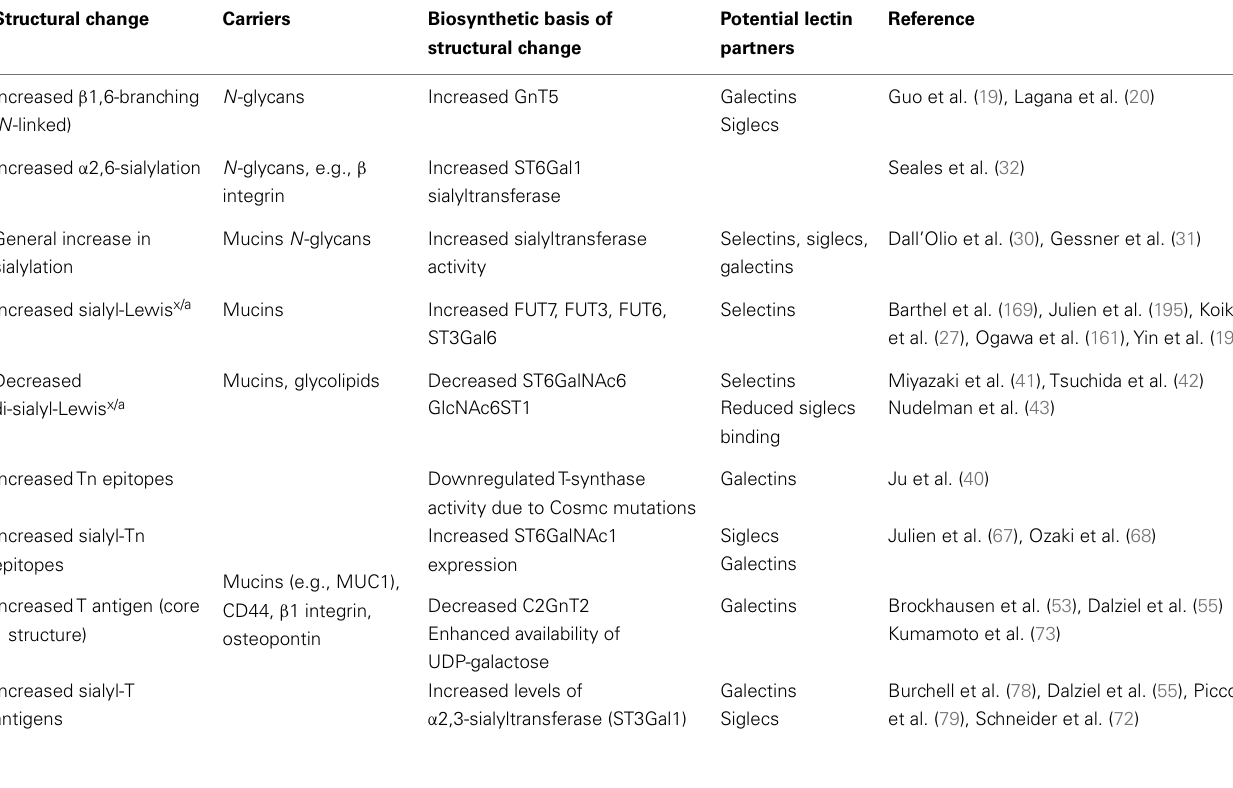
Table 1 | Common glycan alterations on carcinoma cells and their effect on lectin